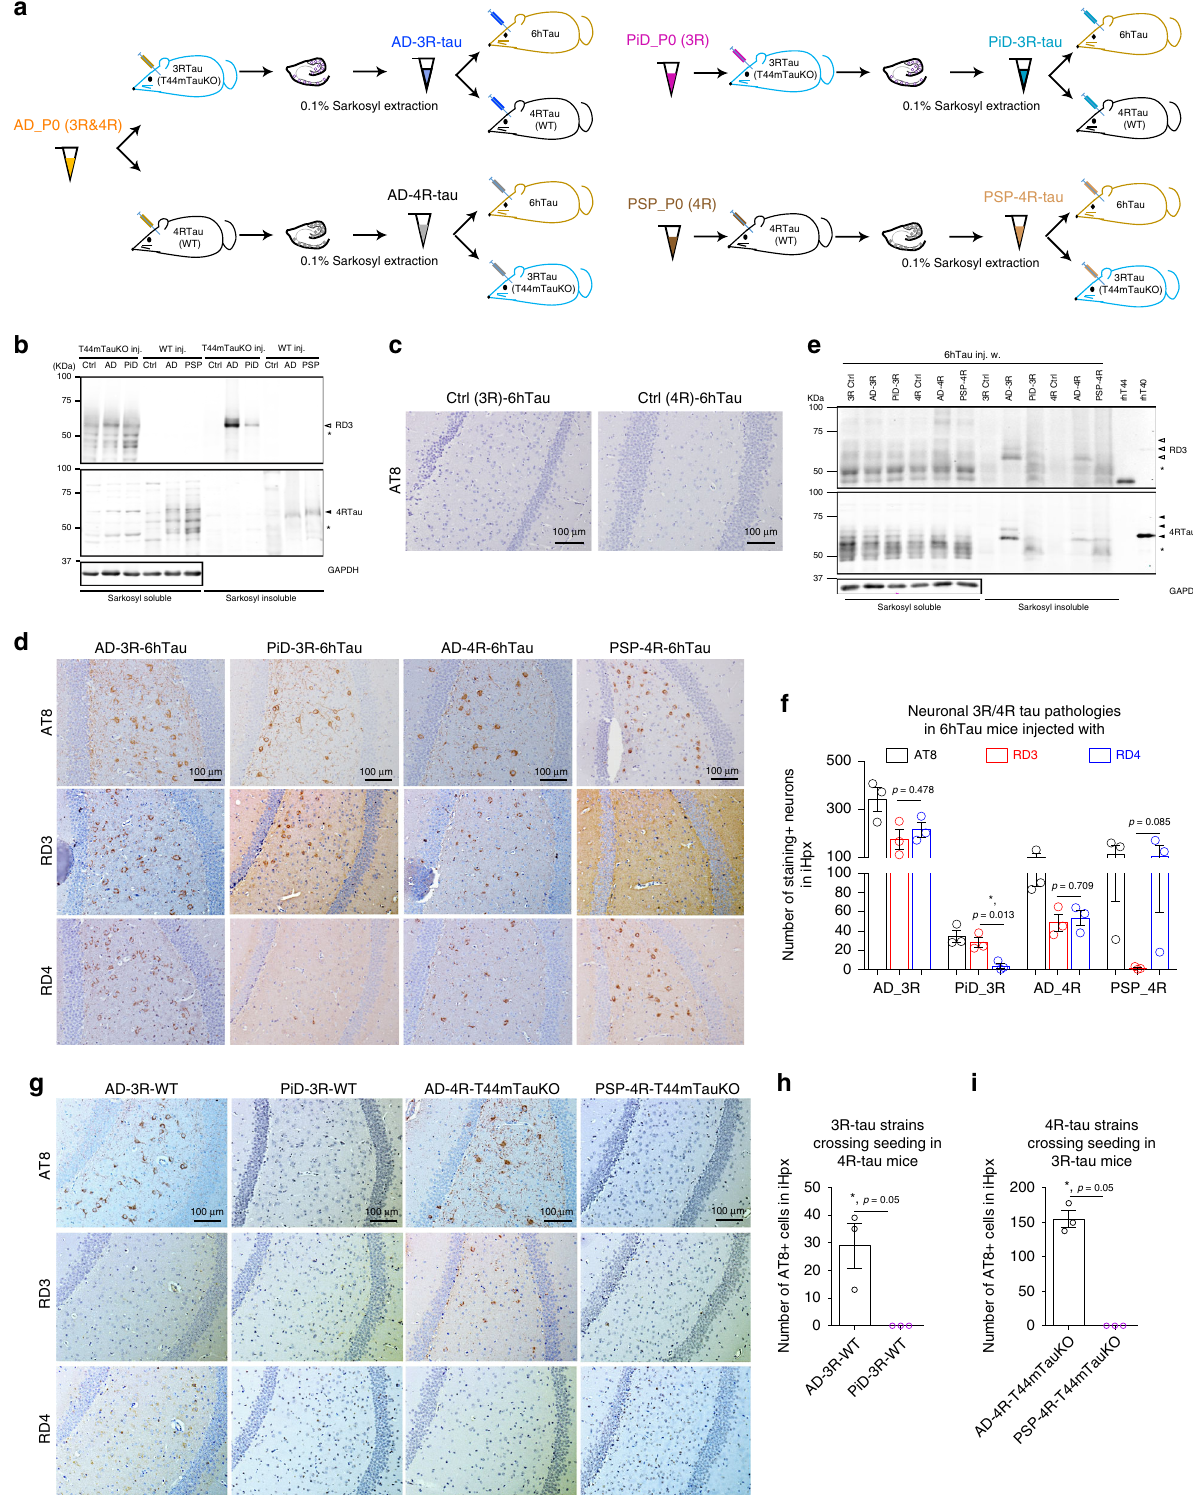
the immune- fl uorescence labeled tau aggregates in CBD_P1/P2- accumulation of insoluble Mtau pathologies by strain_P0 and P1. treated neurons cannot be quanti fi ed due to heavy masking by Moreover, the morphologies of induced tau pathologies by the contaminated proteins. same strain lineages were comparable (Fig. 8e – g). Owing to the Altogether, the in vivo and in vitro data consistently support low potency of PiD strain and the very low purity of pathological that tau strain properties can be faithfully maintained during tau in both CBD_P1 and PiD_P1 (~0.2%), tau aggregates in in vivo transmission. neurons treated with PiD_P0/P1 cannot be detected. Similarly, NATURE COMMUNICATIONS| (2020) 11:7